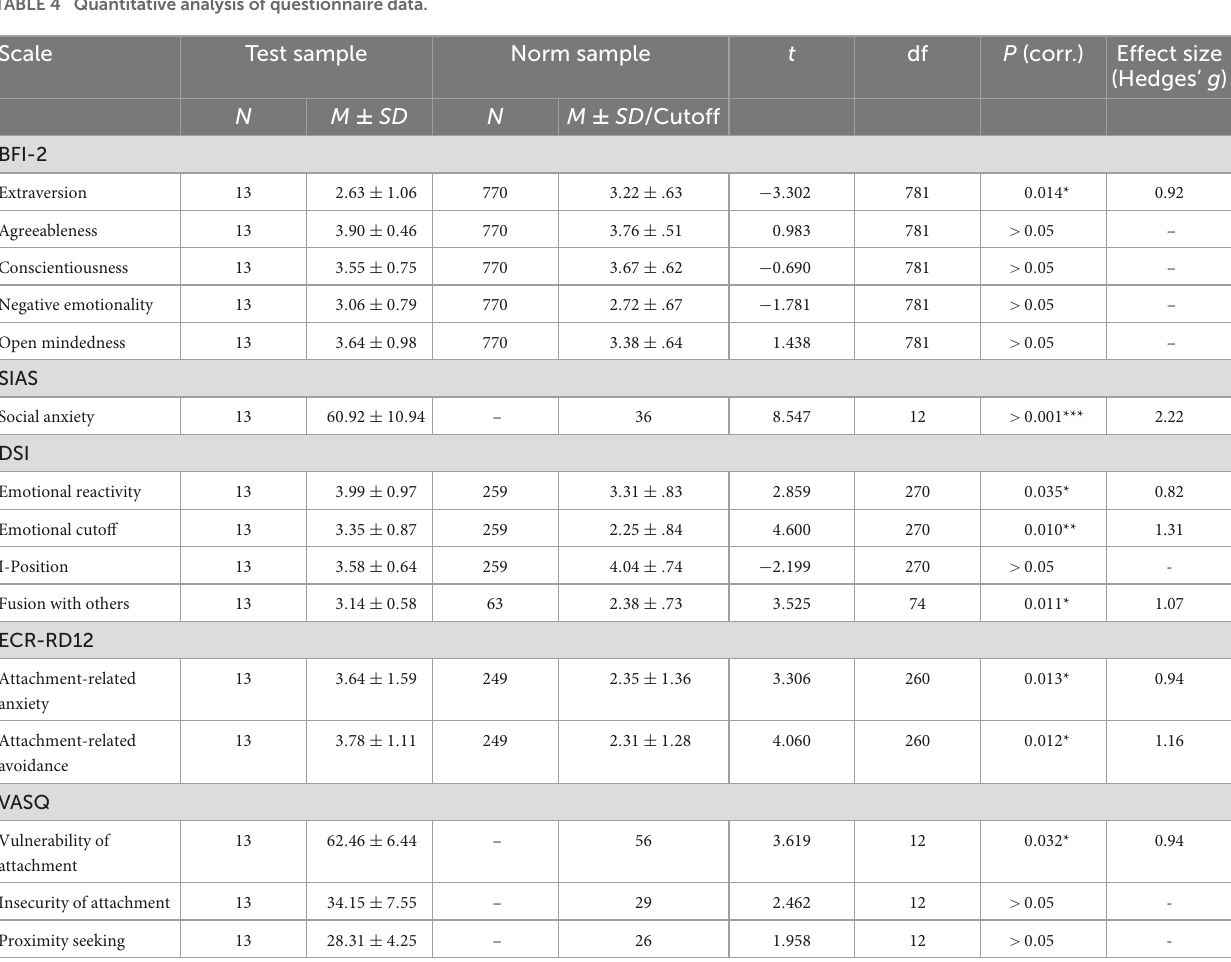
TABLE 4 Quantitative analysis of questionnaire